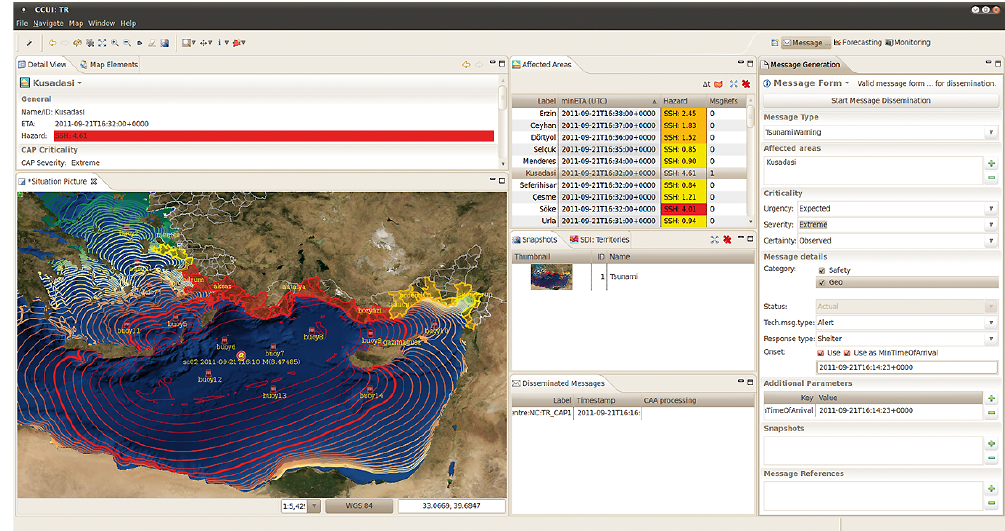
Fig. 5. Message Composition Perspective of CCUI deployed at the Kandilli Observatory and Earthquake Research Institute (KOERI), Turkey (Ozel et al.,